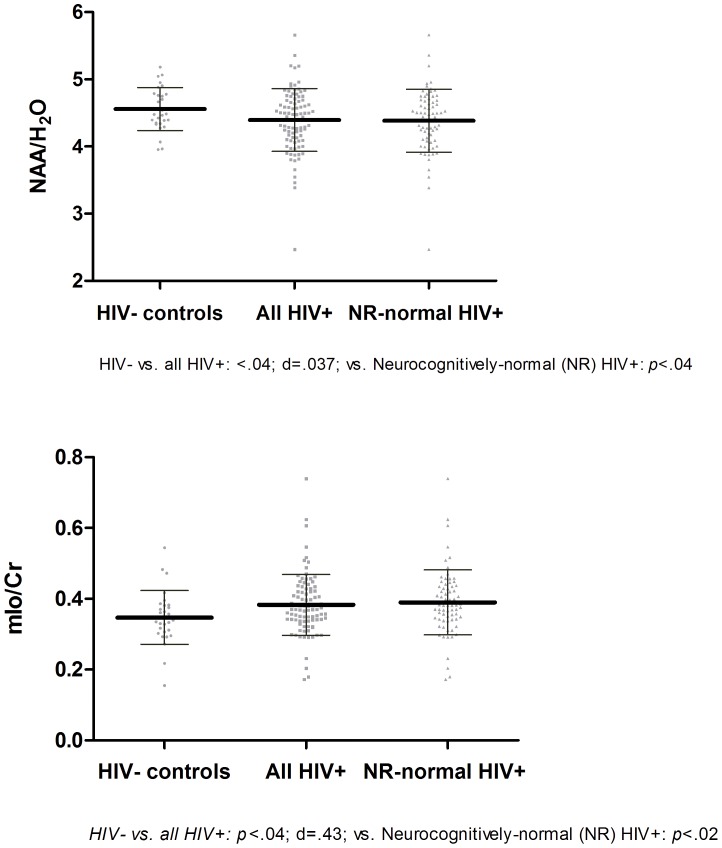
Significant moieties’ difference between the HIV− and HIV+ groups in the Frontal White Matter.